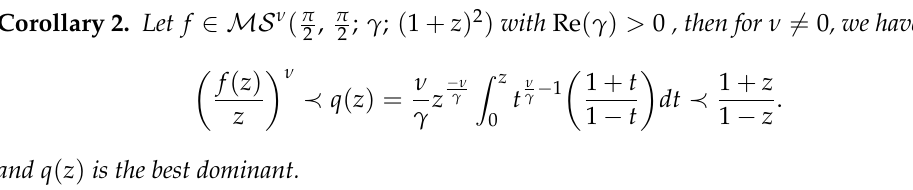
(cid:0) π (cid:1) , 0, ψ ( z ) if ψ ( z ) = 1 + z 2 . 2